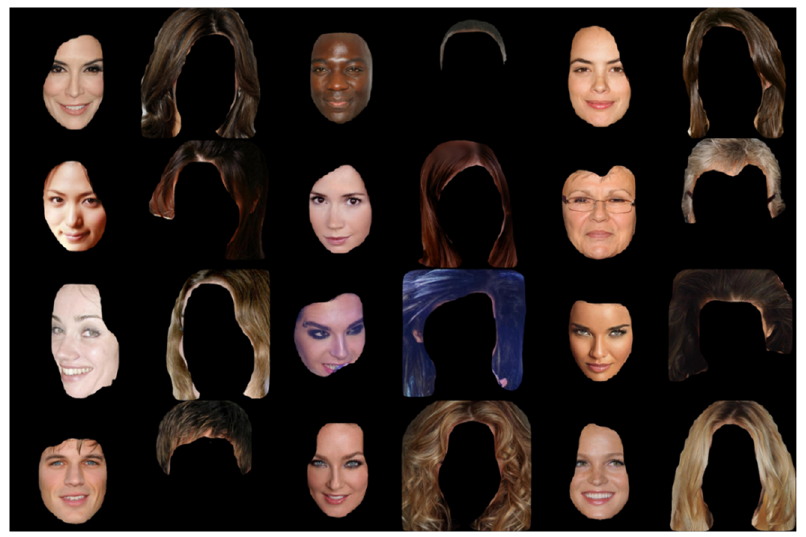
Figure 8. Mask datasets: test results of Mask R-CNN trained with label datasets.